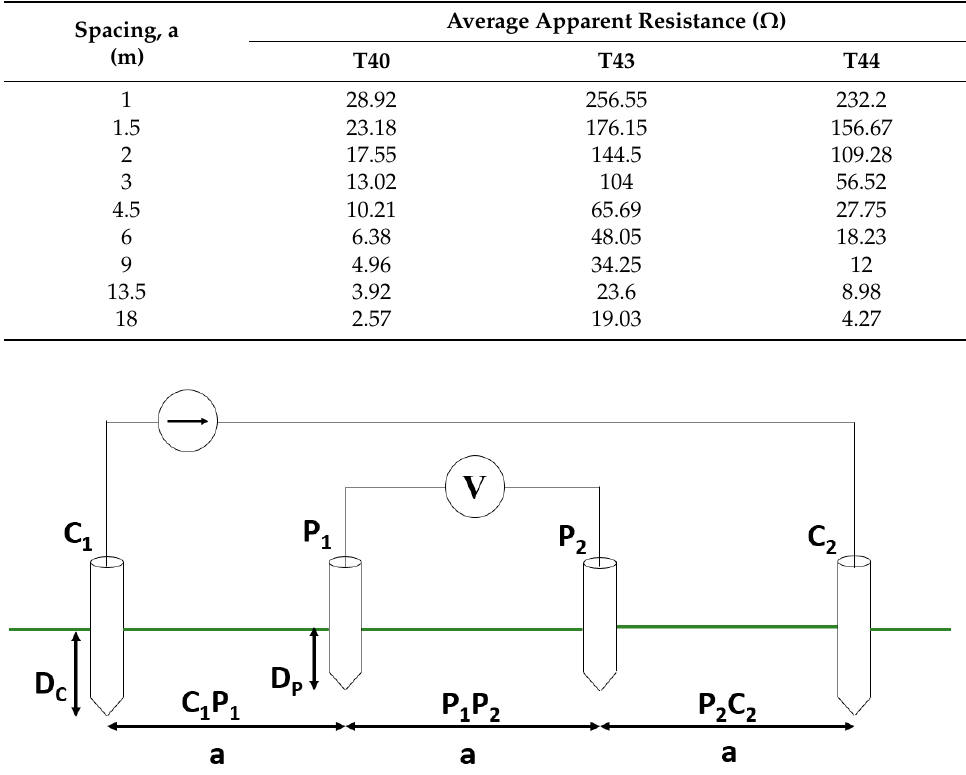
Table 3. Average of apparent resistance ( Ω ) value.